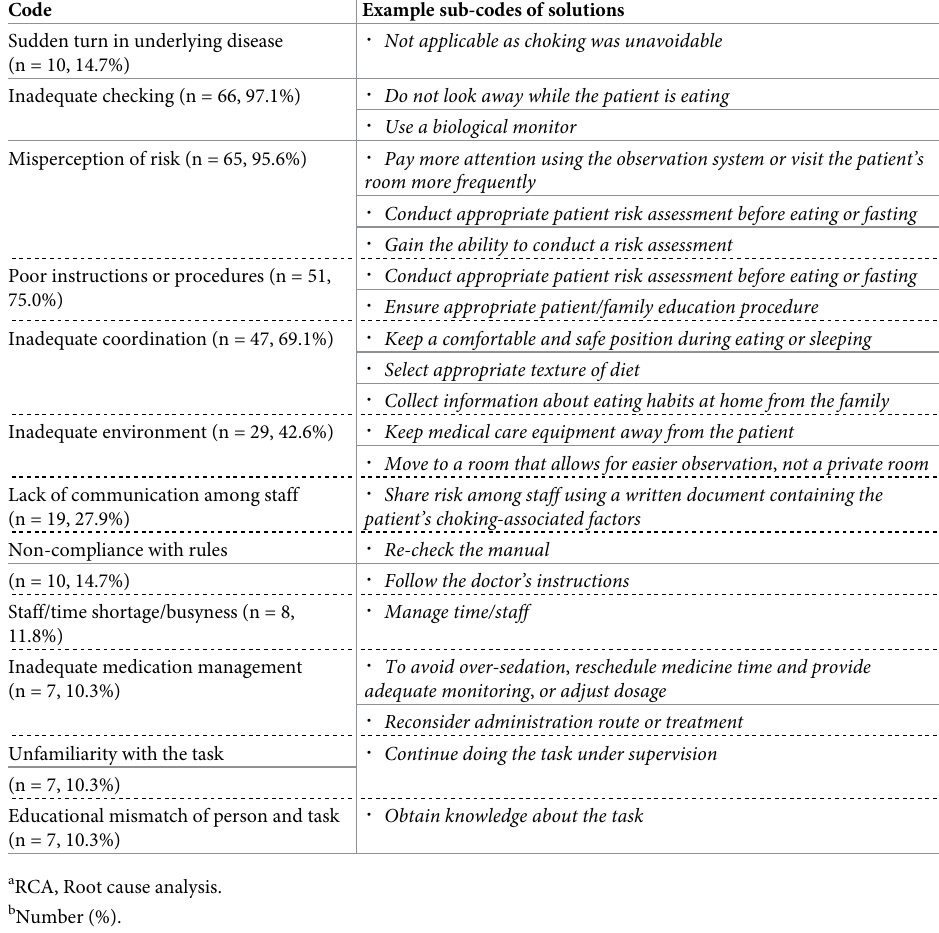
Table 4. Human or systemic contributory factors and solutions related to